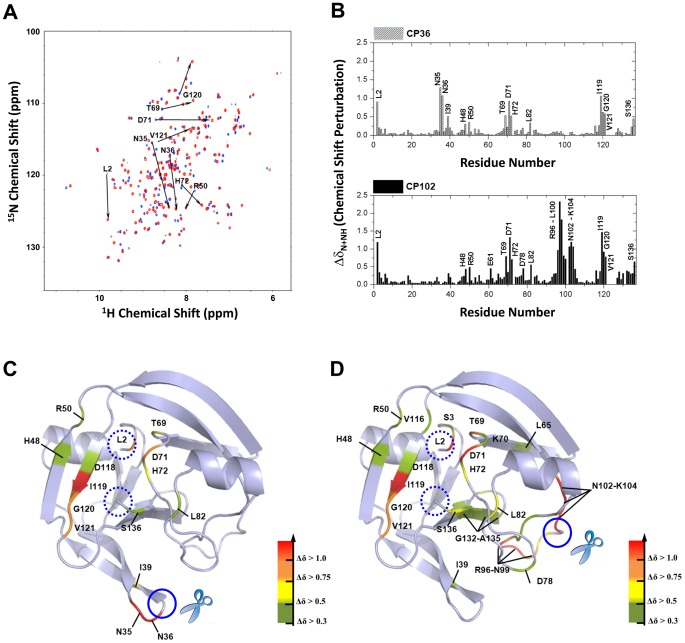
Tertiary structural comparison between CP variants and native NpuInt.(A) Superimposition of the 1H, 15N-HSQC spectra of native NpuInt C1G (blue) and CP36 (red). The spectra were taken at 25°C and 600 MHz. The residues with significant shifts are indicated. (B) Variation in the composite backbone NH and 15N chemical shift perturbation (ΔδN+NH) obtained from the spectra of CP36 and C1G (upper panel) and CP102 and C1G (lower panel), where ΔδN+NH = [(ΔδNH
2+ΔδN
2/25)/2]1/2. ΔδNH and ΔδN were calculated from the differences for backbone NH and 15N, respectively. Spatial distribution of residues with significant ΔδN+NH are mapped onto the NpuInt structure (PDB code: 2KEQ) [23], as indicated in different colors for (C) CP36 and (D) CP102. Dotted circles indicate the locations of the N- and C-terminal ends, and closed circles indicate the introduced CP sites.